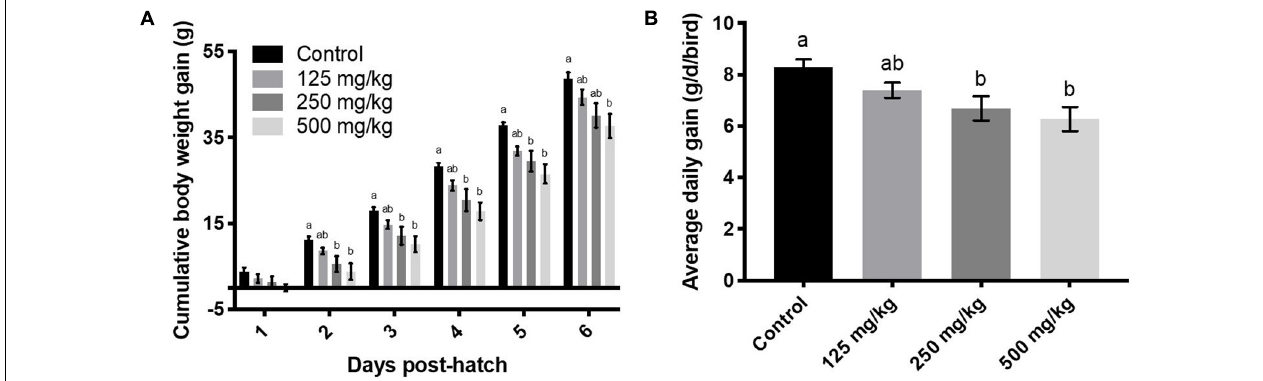
FIGURE 2 | Body weight gain cumulatively (A) , and on an average daily basis (B) . Values represent least squares means ± SEM ( n = 12–13). Different superscripts within each day indicate a significant difference at P < 0.05; Tukey’s test.